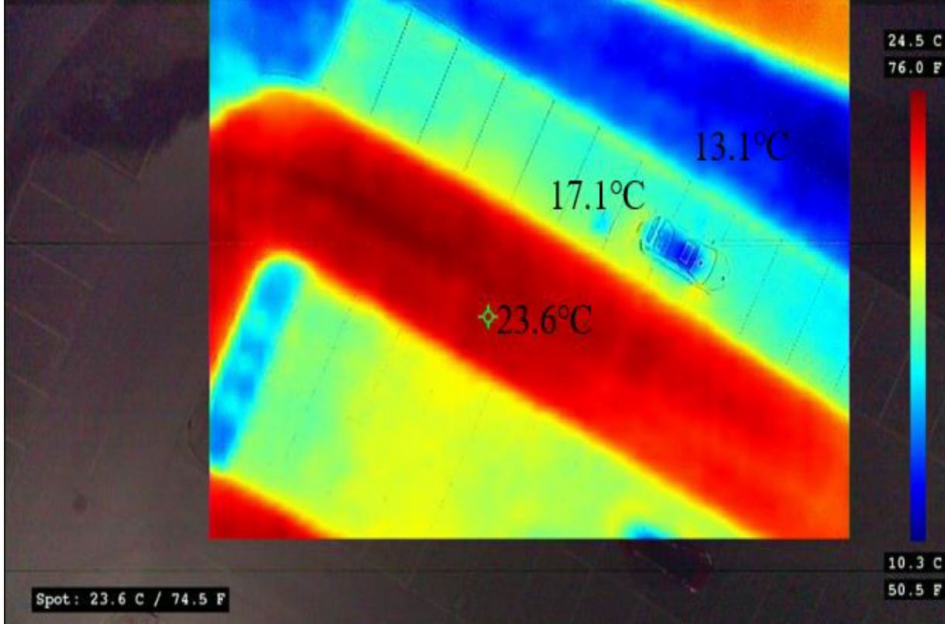
Figure 7. Thermal image example of the differences between land surface temperatures of different